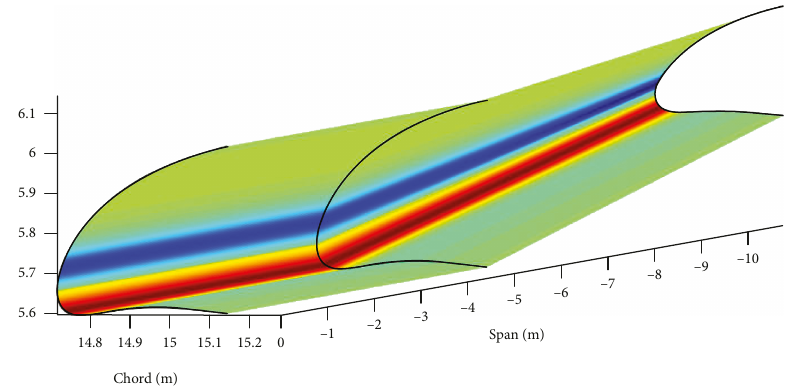
Figure 20: 3D optimal morphing shape and curvature di ff erence.